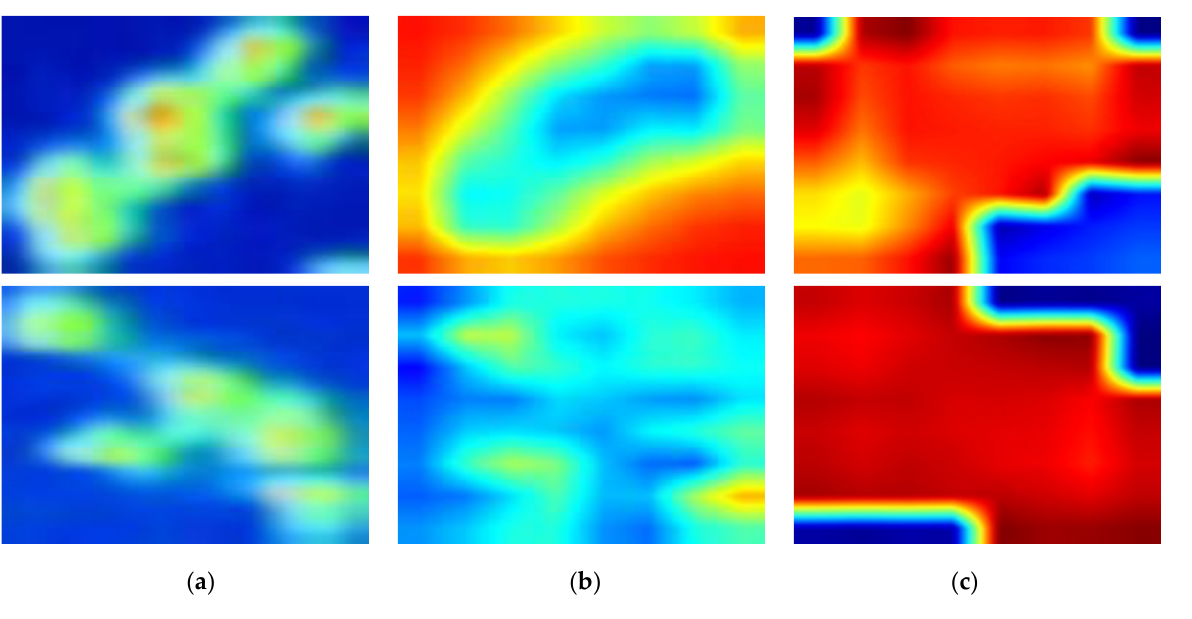
Figure 5. The target features and their features obtained by max-pooling and maximum-no-pooling, respectively: ( a ) target original features; ( b ) features by max-pooling; ( c ) features by maximum-no-pooling.